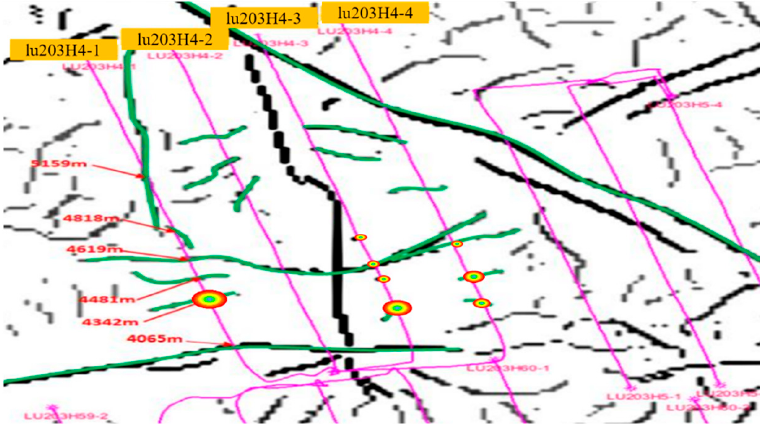
Figure 5. The relationship between the deformation location and fault.